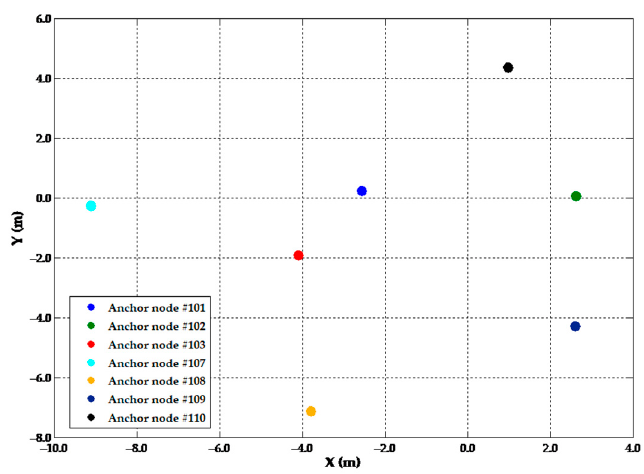
Figure 5. Plane location distribution of anchor nodes.